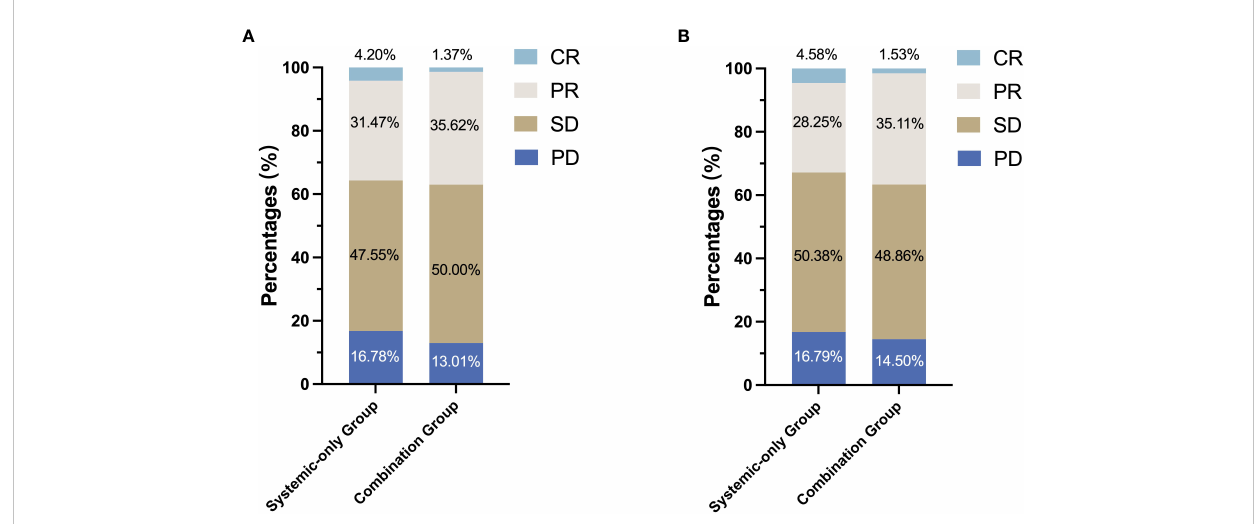
FIGURE 3 Tumor responses rates based on RECIST v1.1 in the systemic-only group and the combination group (A) before PSM and (B) after PSM. RECIST, Response Evaluation Criteria in Solid Tumors; PSM, propensity score matching; CR, complete response; PR, partial response; SD, stable disease; PD, progressive disease.